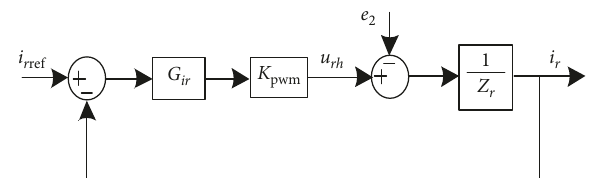
Figure 4: Current control block diagram of the rotor-side